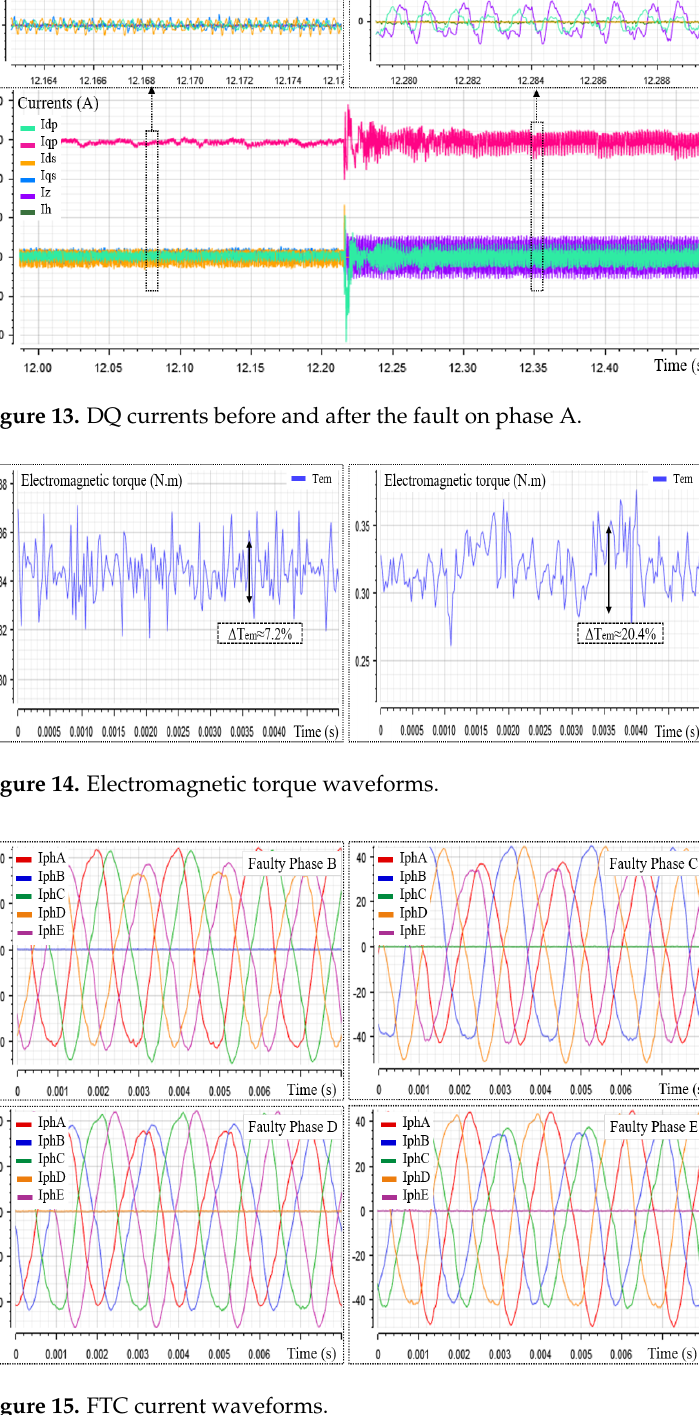
Figure 15. FTC current waveforms.